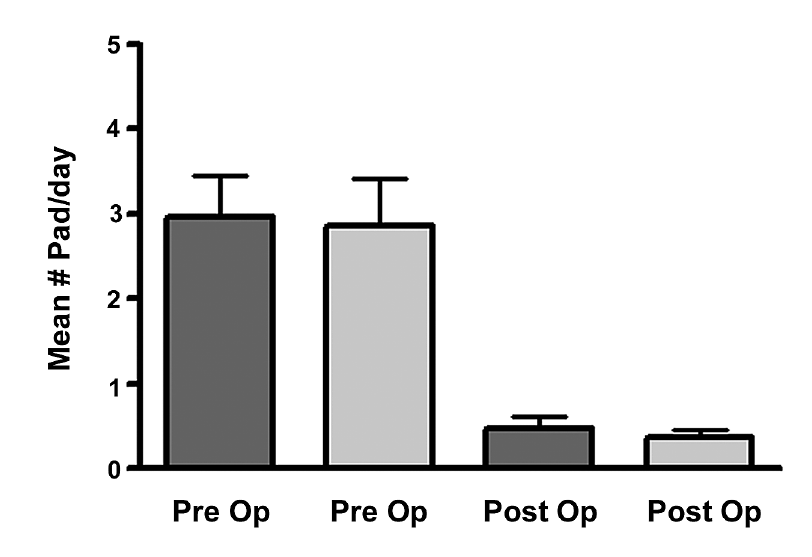
Figure 2 – Mean pad use per day. Group A = dark grey bars; Group B = light grey bars.